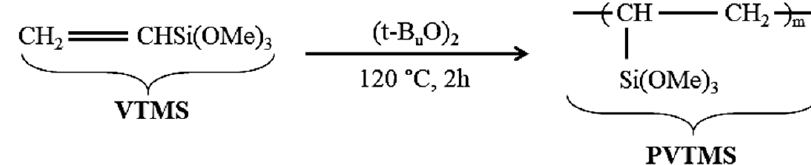
Figure 3. Synthesis route of PVTMS.